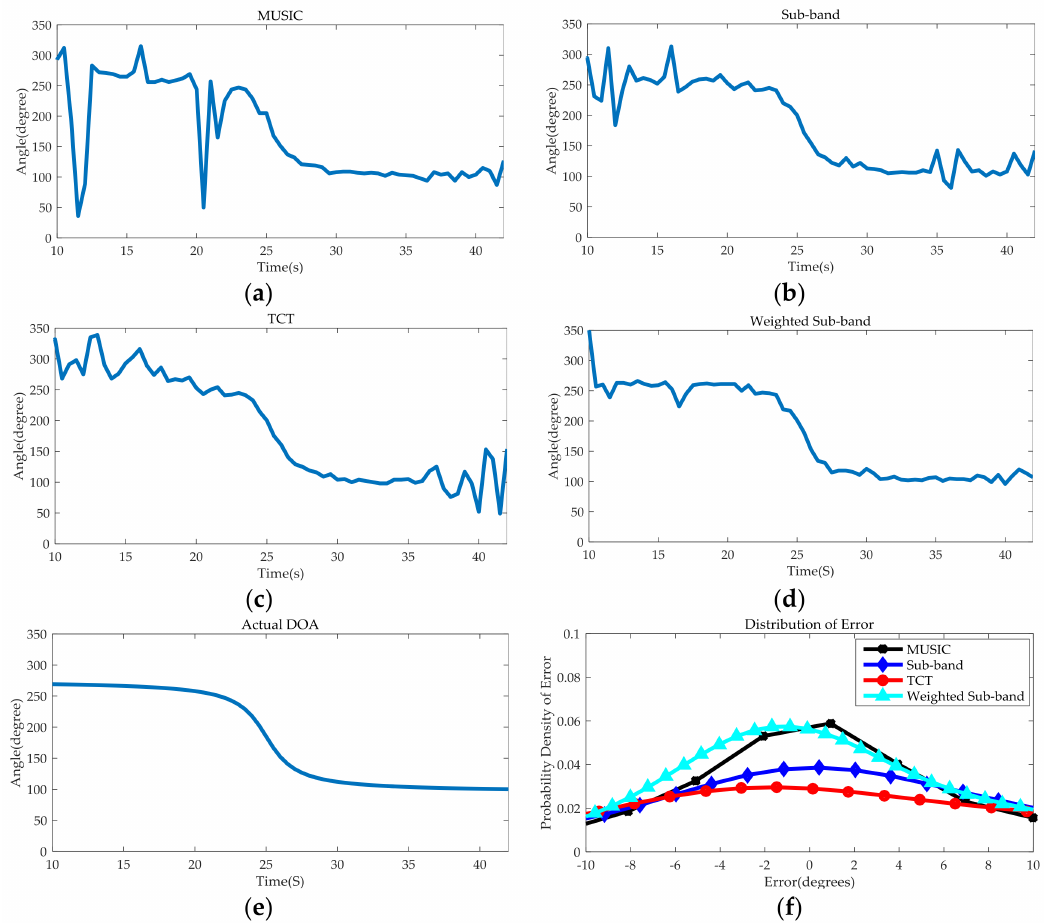
Figure 13. ( a ) The DOA estimation results of MUSIC method at level 4 wind. ( b ) The DOA estimation results of Sub-band method at level 4 wind. ( c ) The DOA estimation results of TCT method at level 4 wind. ( d ) The DOA estimation results of Weighted Sub-band method at level 4 wind. ( e ) The actual DOA. ( f ) The distributions of the DOA errors for four